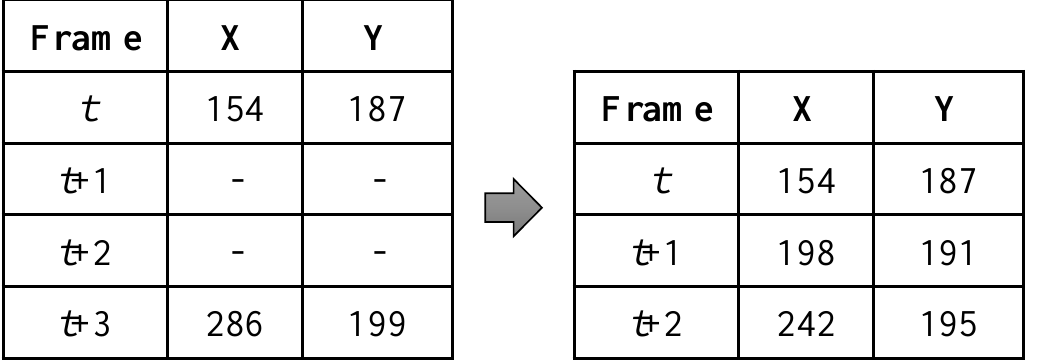
Figure 4. Estimation of finger area when no label remains.